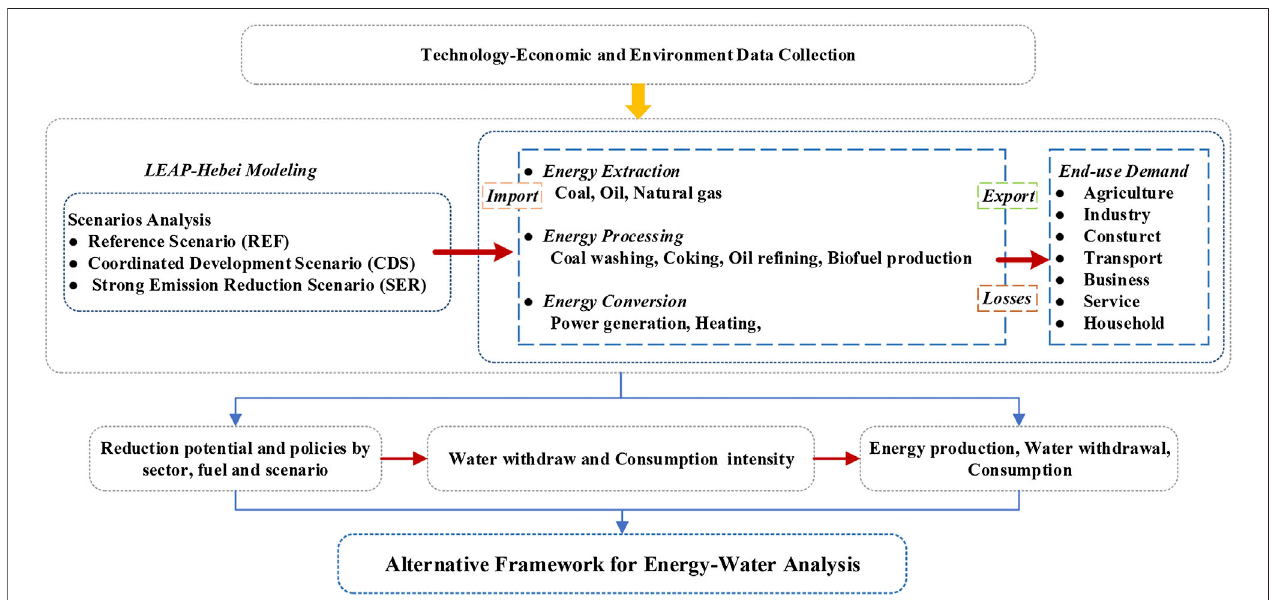
FIGURE 2 | The model ’ s